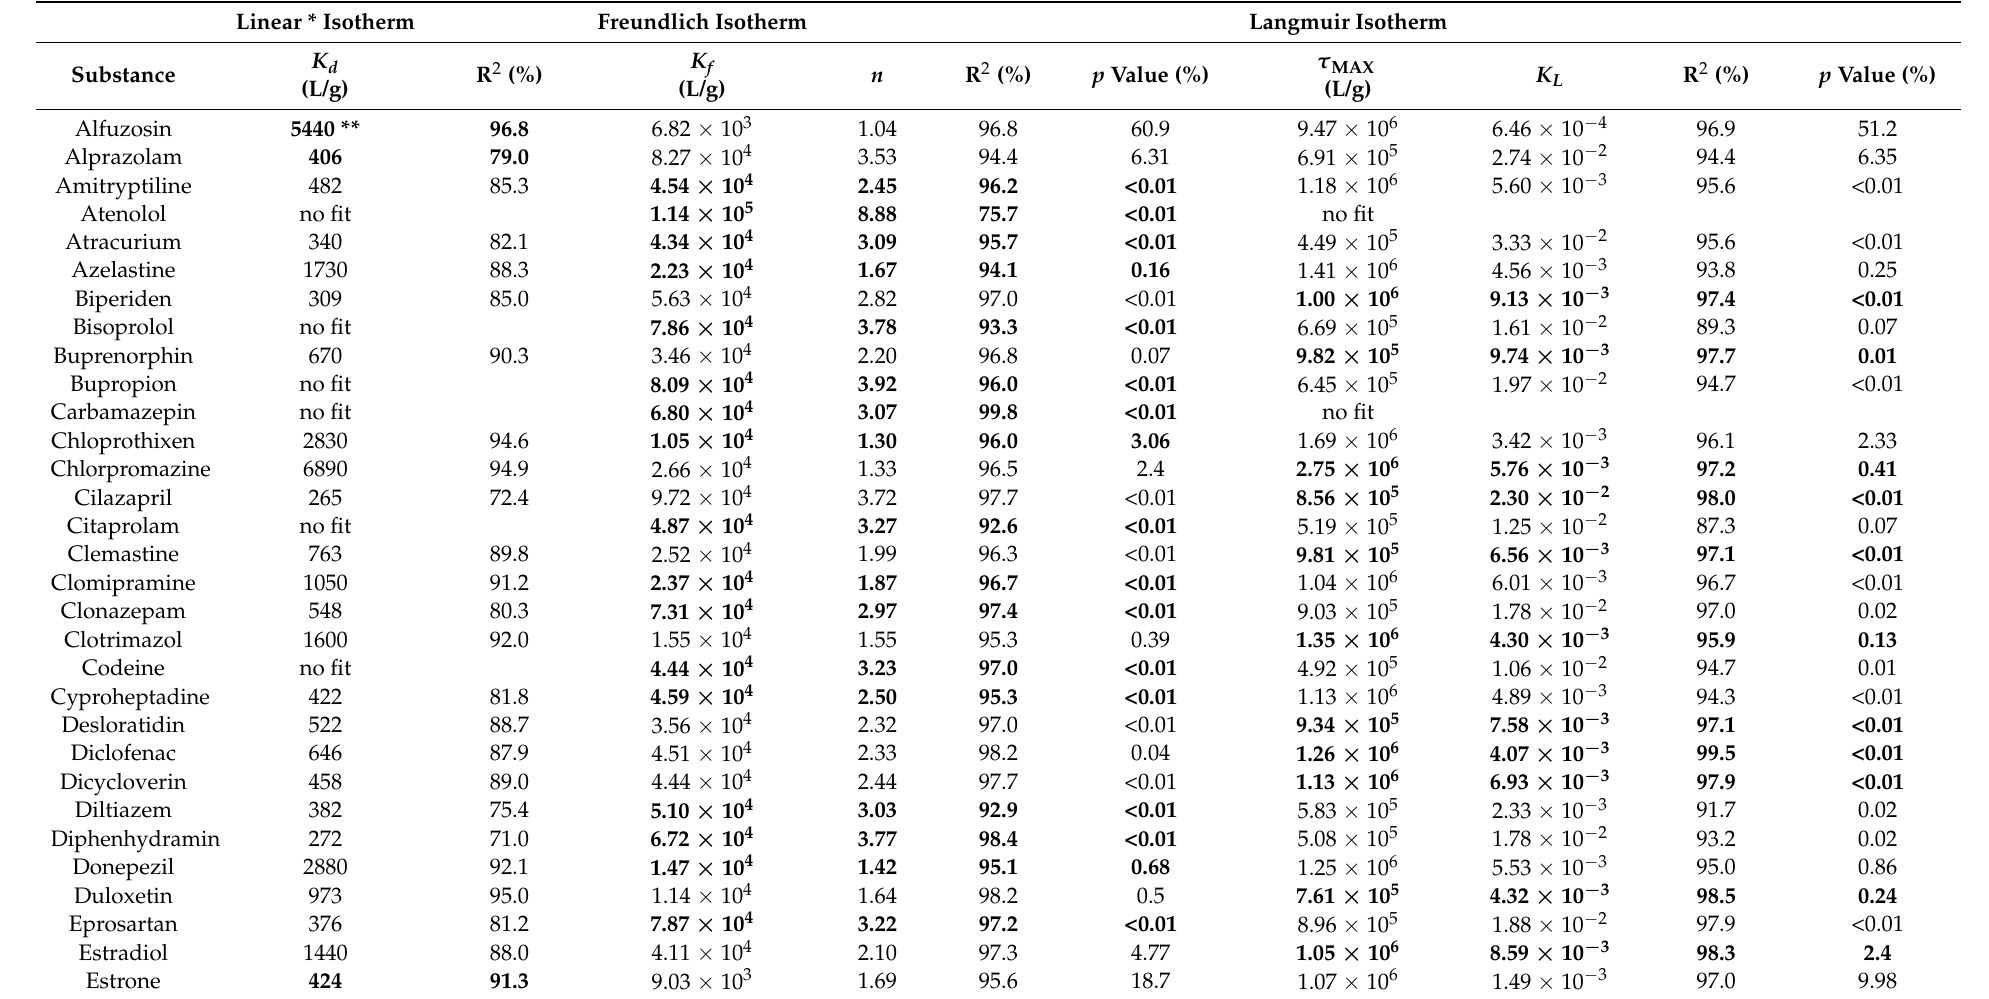
Table 2. Sorption isotherms obtained during sorption to PAC. Included here is the linear sorption coefficient K d , Freundlich coefficient and exponent K f and n , respectively, and for the Langmuir isotherm, the Langmuir coefficients K L and τ represent the total number of surface sites per mass of